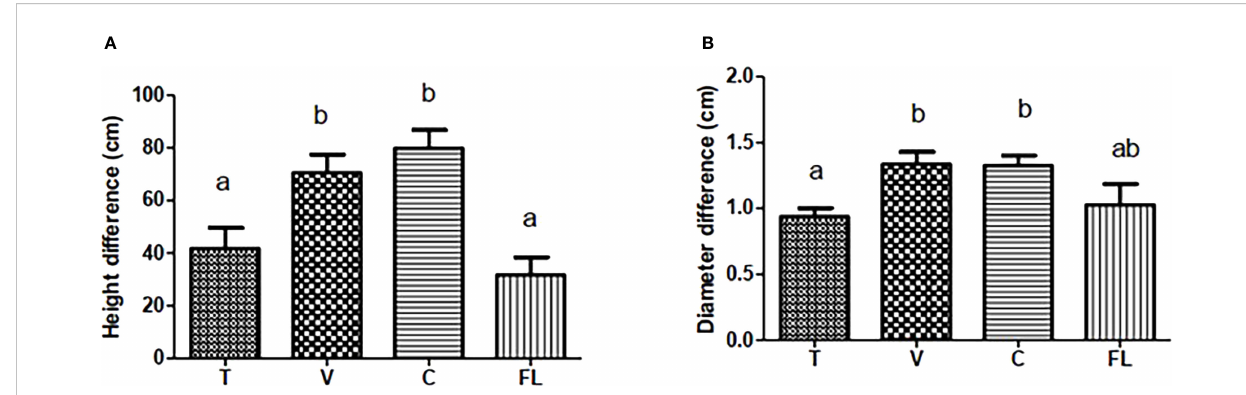
FIGURE 8 Mean values of control treatment (T), vermicompost (V), compost (C), and liquid fertilizer (FL). Signi fi cant differences are shown in (A, B) . References: (A) differences in plant height and (B) differences in plant diameter between two consecutive years (adapted from